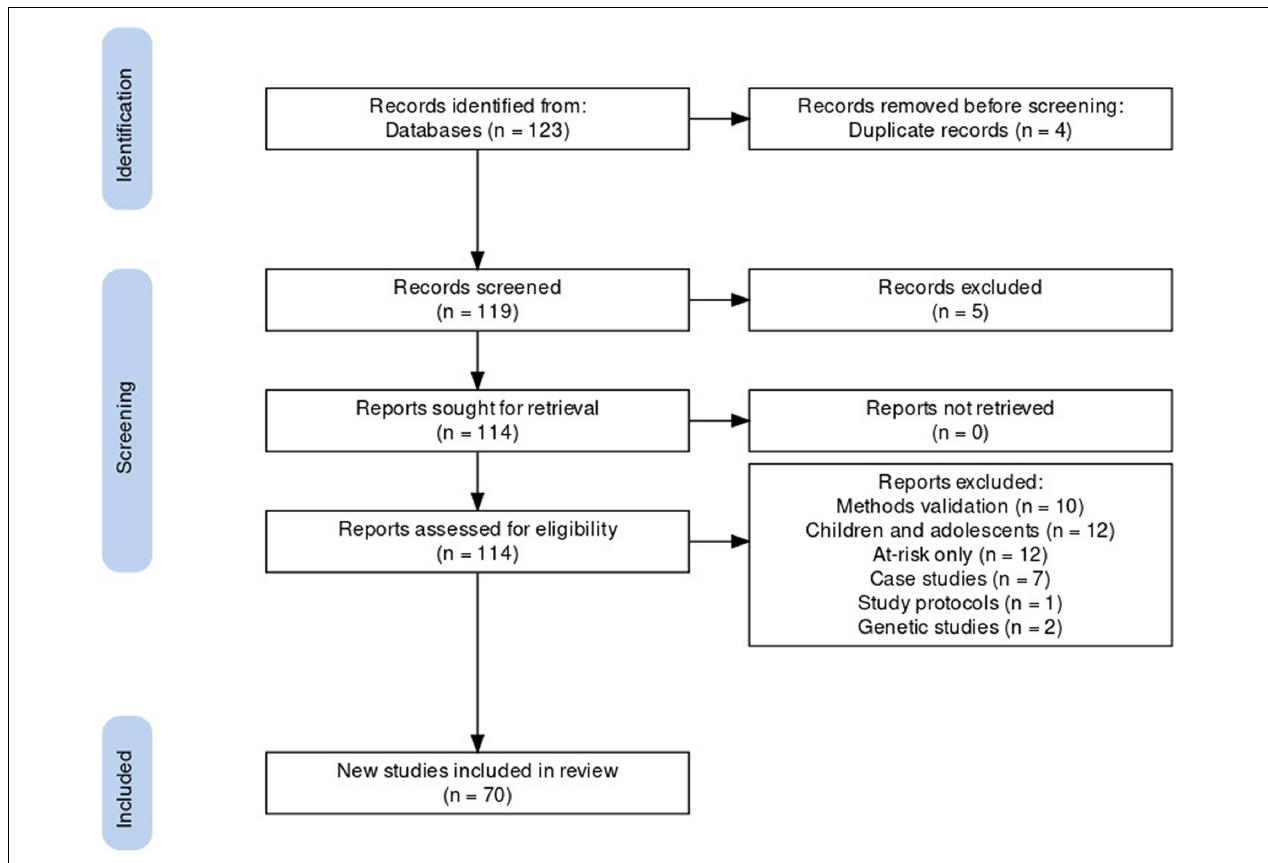
FIGURE 1 | Study selection flow